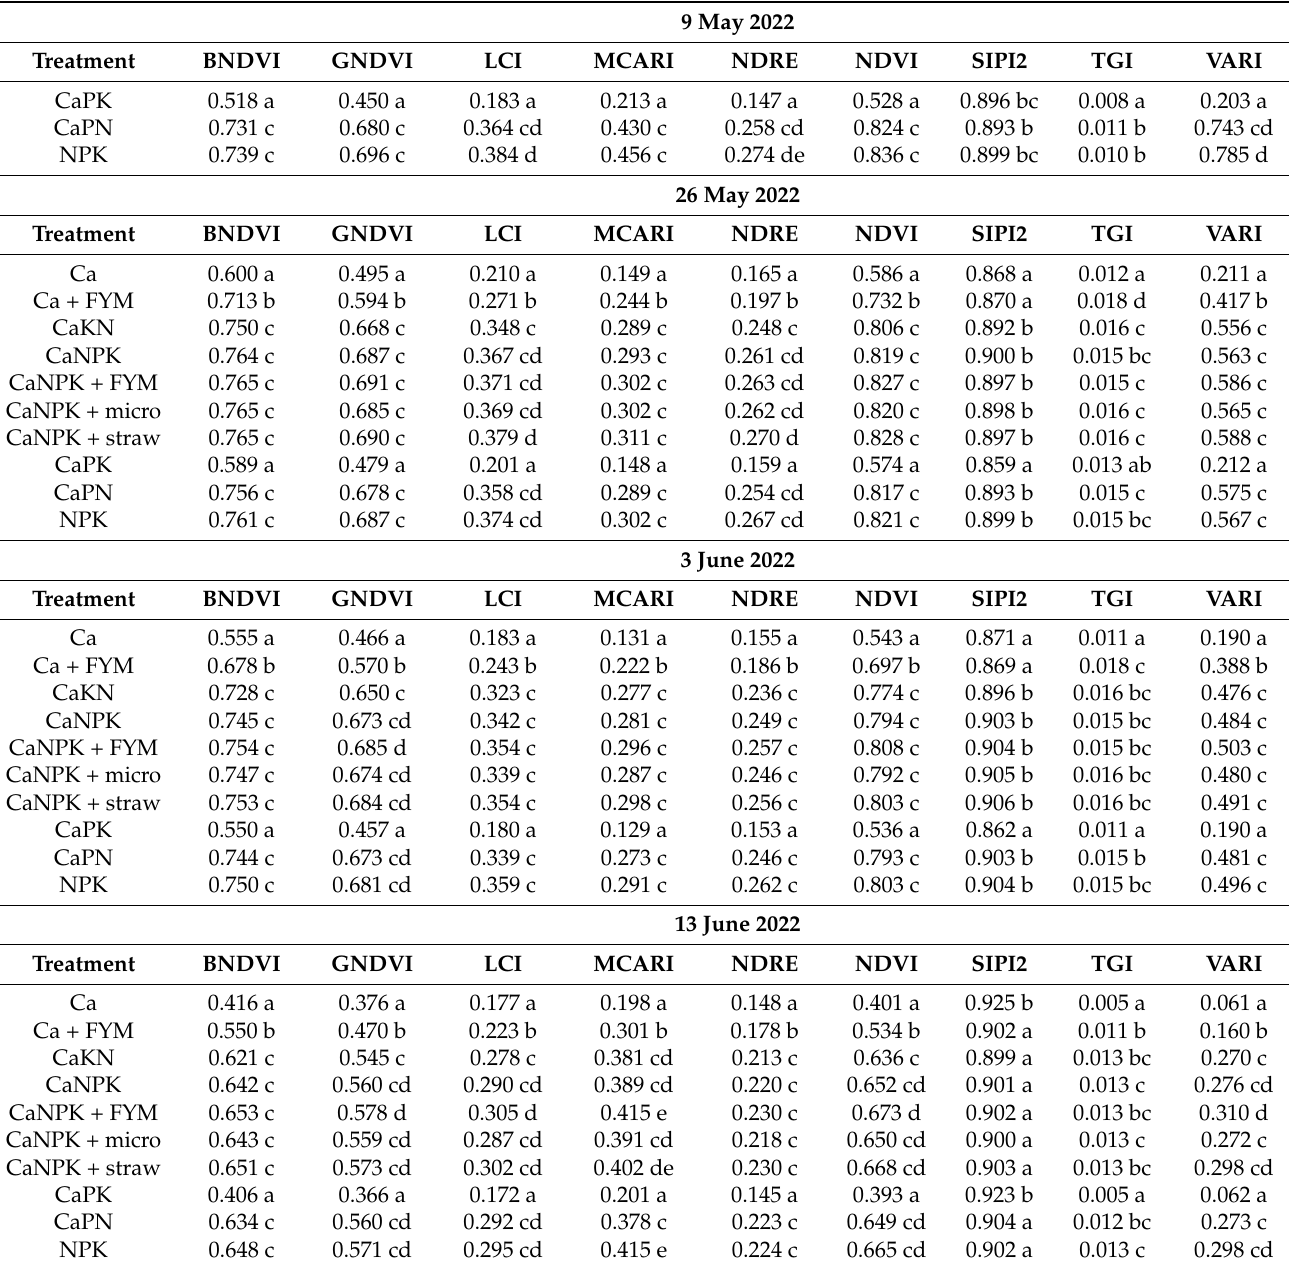
* different letters within column indicate significant differences between the means at 0.05 significance level. Abbreviations: NDVI—Normalized Difference Vegetation Index, NDRE—Normalized Difference Red Edge Index, VARI—Visible Atmospherically Resistant Index, TGI—Triangular Greenness Index, SIPI2—Structure Insensitive Pigment Index 2, LCI—Leaf Chlorophyll Index, BNDVI—Blue Normalized Difference Vegetation Index,